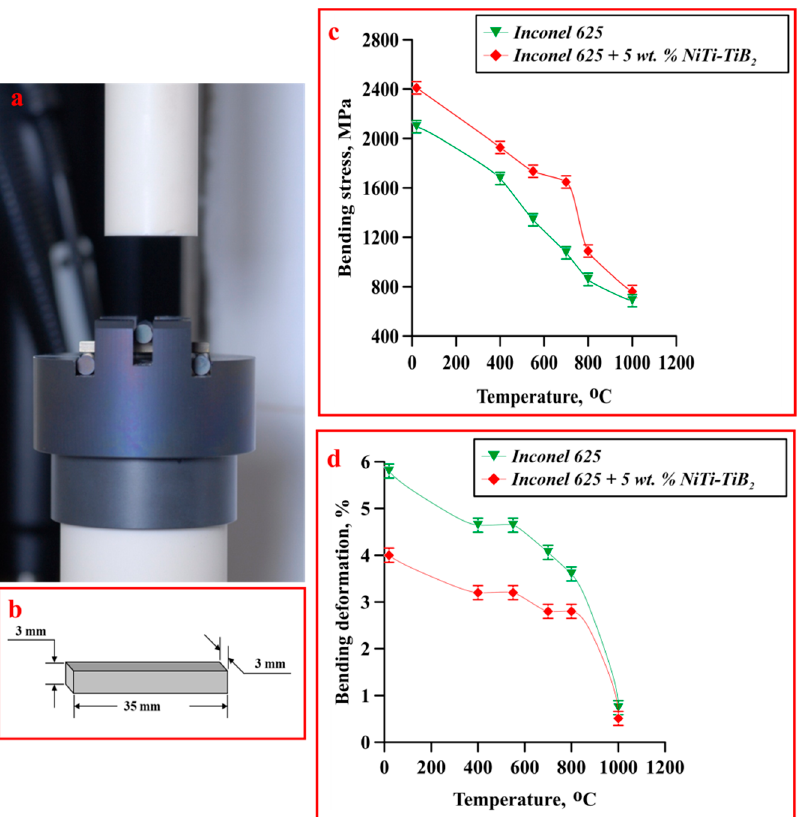
Figure 6. ( a ) Appearance of the three-point bending tester; ( b ) a schematic representation of the shape and dimensions of the 95 wt% Inconel 625 + 5 wt% NiTi–TiB 2 sample; dependencies of bending strength and bending deformation rate of samples after three-point bending tests conducted at room ( c ) and at elevated ( d ) temperatures.